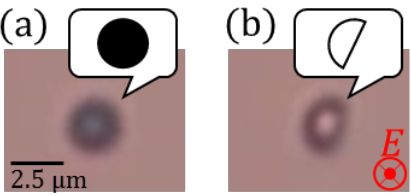
Figure 7. AC electric field response of a silver coated hemispherical Janus particle. ( a ) Without an electric field, the metal surface was horizontally oriented (perpendicularly to the direction of gravity). ( b ) With